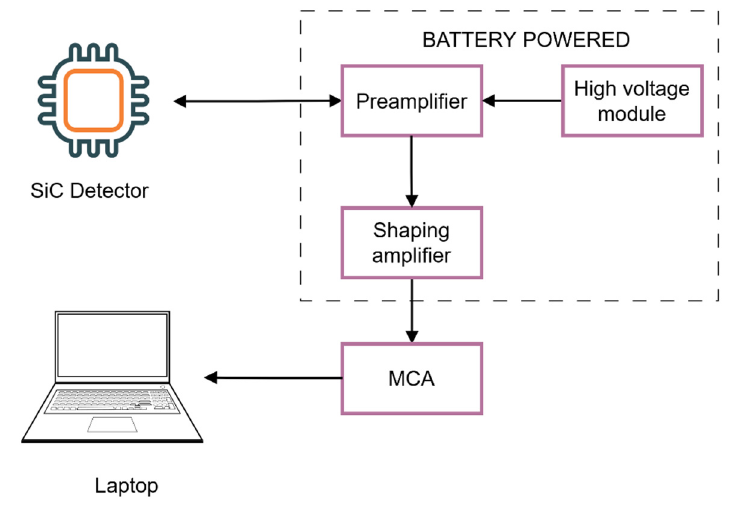
Figure 2. Block diagram of the detector system used in this study.